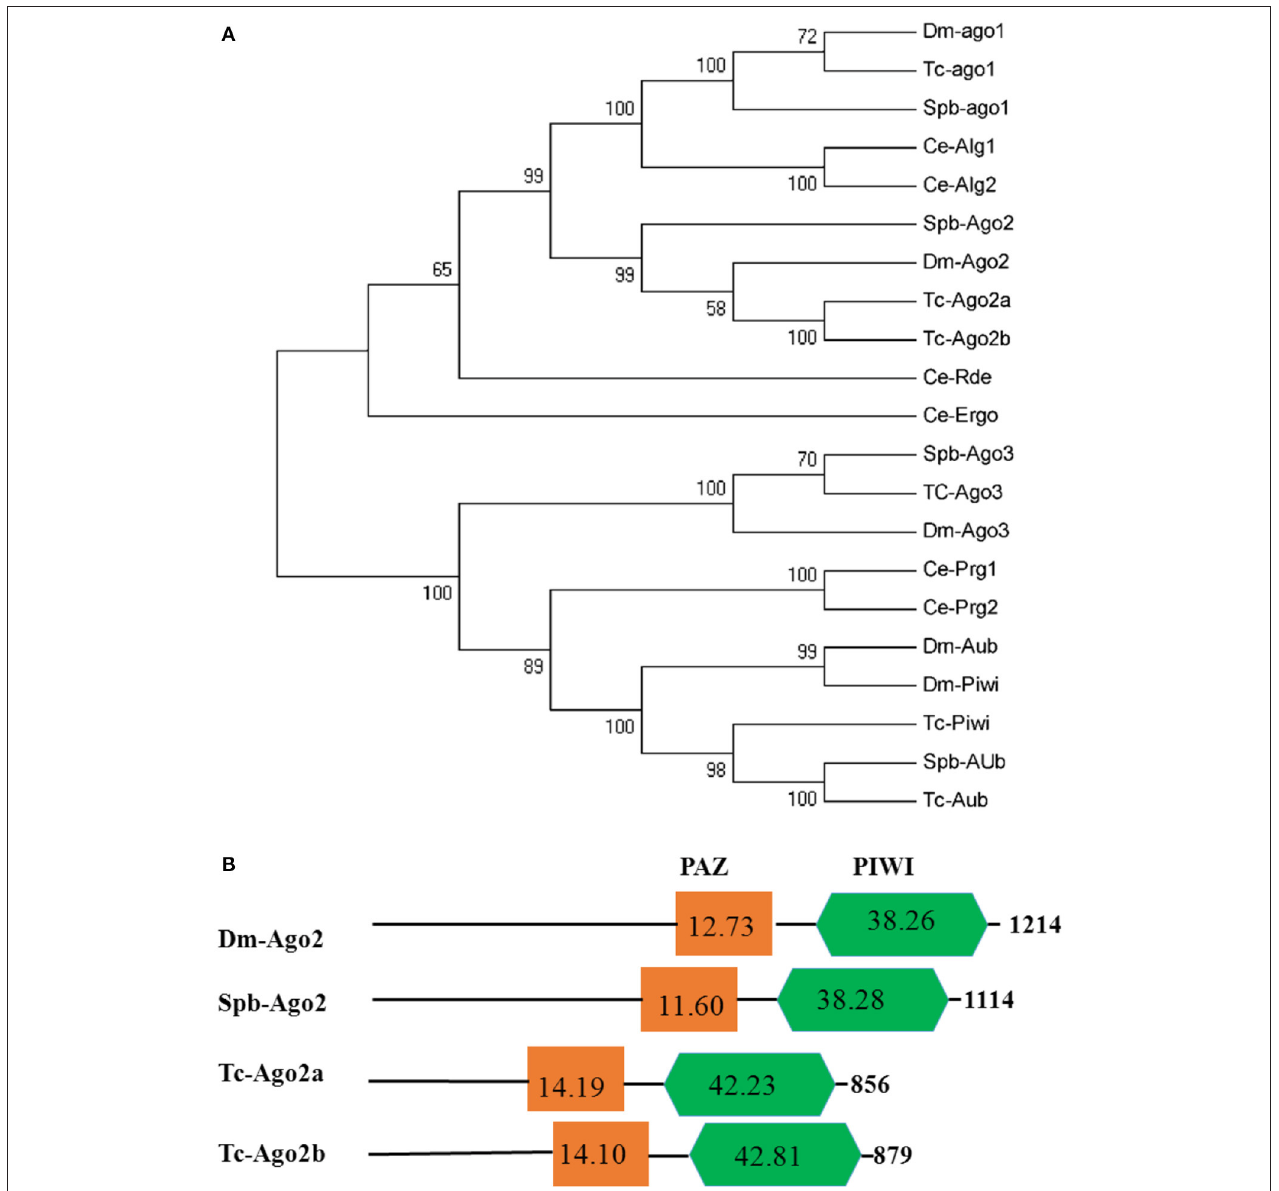
FIGURE 5 | Phylogenetic and domain architecture analysis of Argonaute proteins. (A) Neighbor-joining inferred phylogenetic relationships among insect Argonaute proteins, including Dm-ago1 (NP_725341), Tc-ago1 (EFA09197), Spb-ago1 (C70013), CeAlg1 (CAA93496), CeAlg2 (CCD73271), Spb-ago2 (C65749),